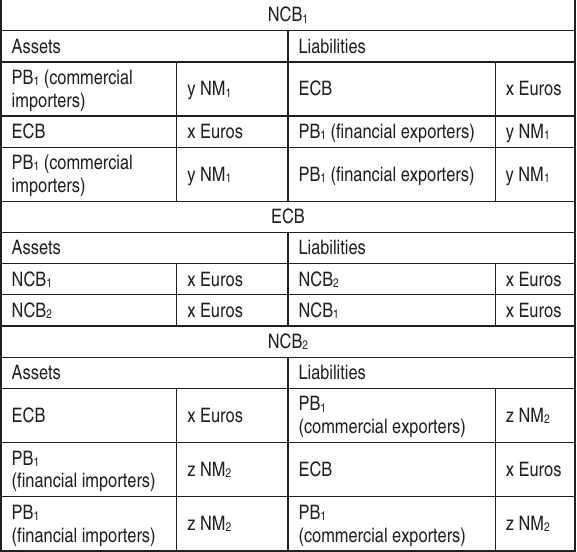
Table 5. Final settlement of cross-border